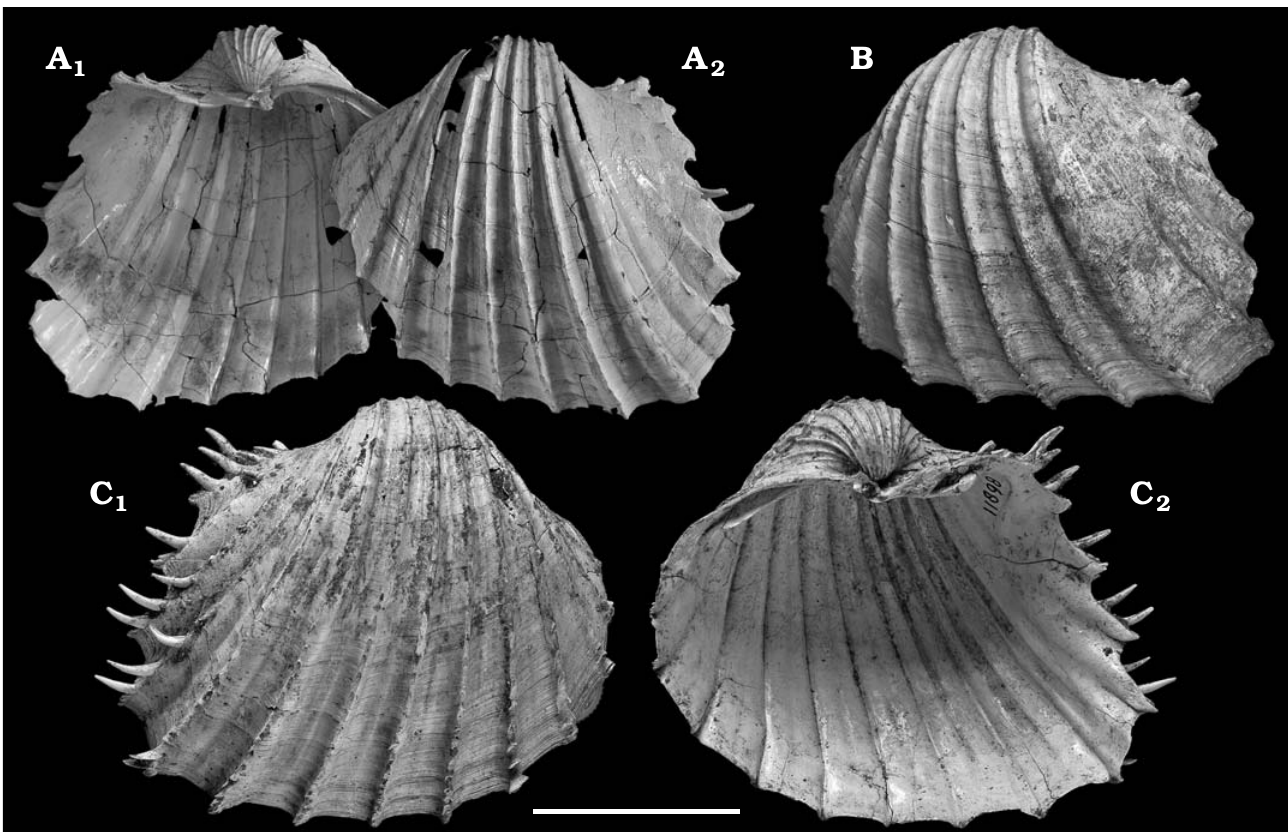
Fig. 7. Cardiid bivalve Procardium kunstleri (Cossmann and Peyrot, 1912) from Serravallian (Miocene) of France. A . RGM.794109, Salles, “Moulin Débat”; internal (A 1 ) and external (A 2 ) views. B . RGM.1309992 (Kaptein collection), Gironde; external view. C . PH 11898, Salles; internal (C 1 ) and external (C 2 ) views. Scale bar 50